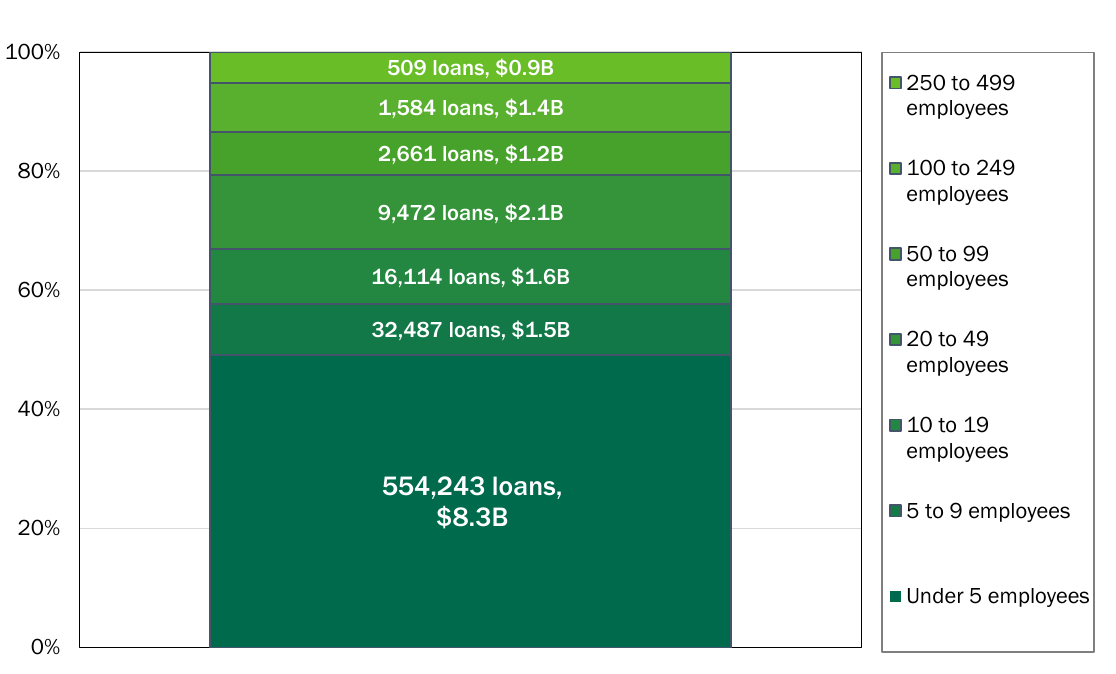
Figure 2. Paycheck Protection Program (PPP) Loan Recipients in Agriculture by Business Size